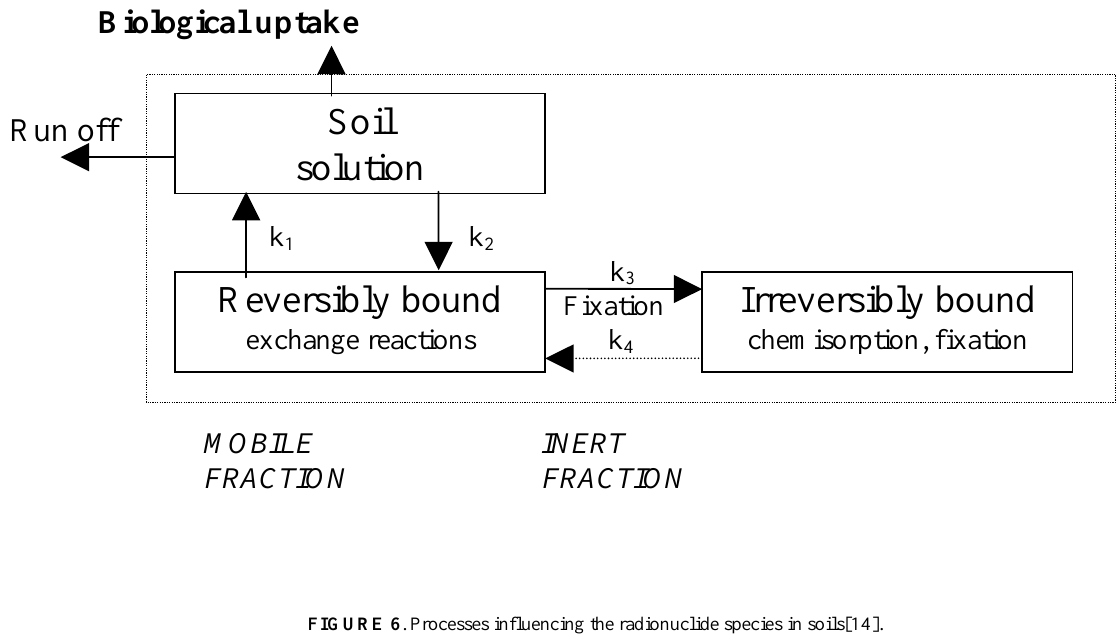
FIGURE 6 . Processes influencing the radionuclide species in soils[14].